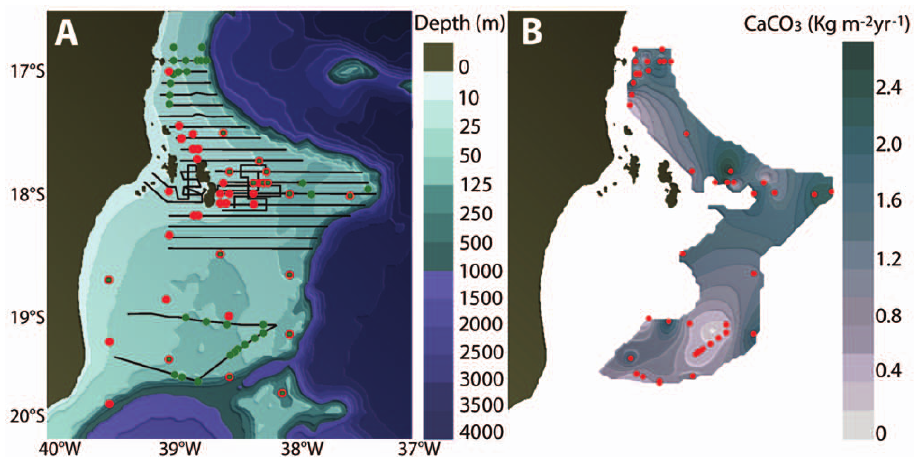
Figure 2. The study region off eastern South America, Abrolhos Bank. (A) Bathymetric map showing the areas surveyed with SSS (black lines), ROV ground truth sites (red dots) and mixed-gas dive collecting sites (green dots). (B) Distribution, and annual calcium carbonate production of rhodolith beds. The gray area indicates the total area occupied by the rhodolith beds, whereas the gray scale variations correspond to estimates of the annual calcium carbonate production (expressed as kg m 2 2 yr 2 1 ).